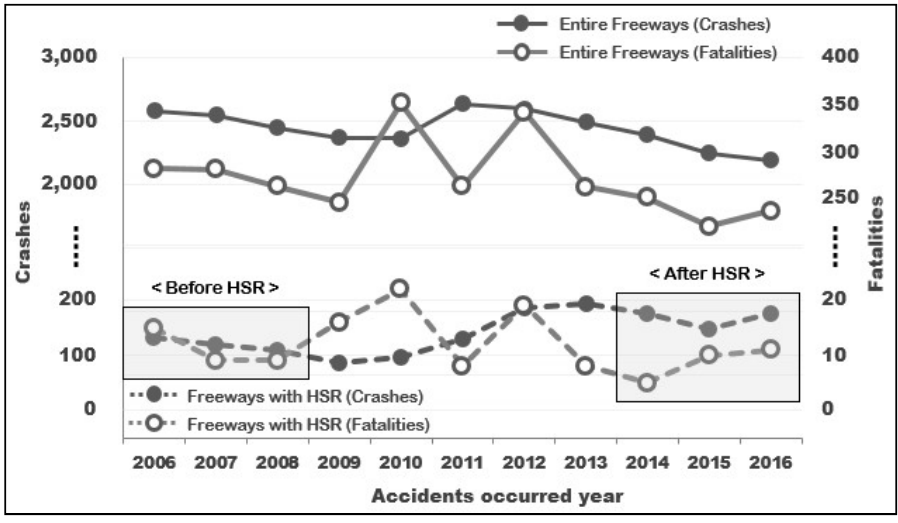
Figure 1. Annual crash frequency before and after hard shoulder running.